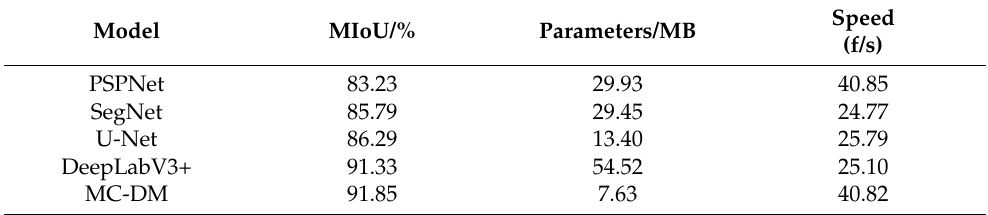
Table 7. Evaluation results of different